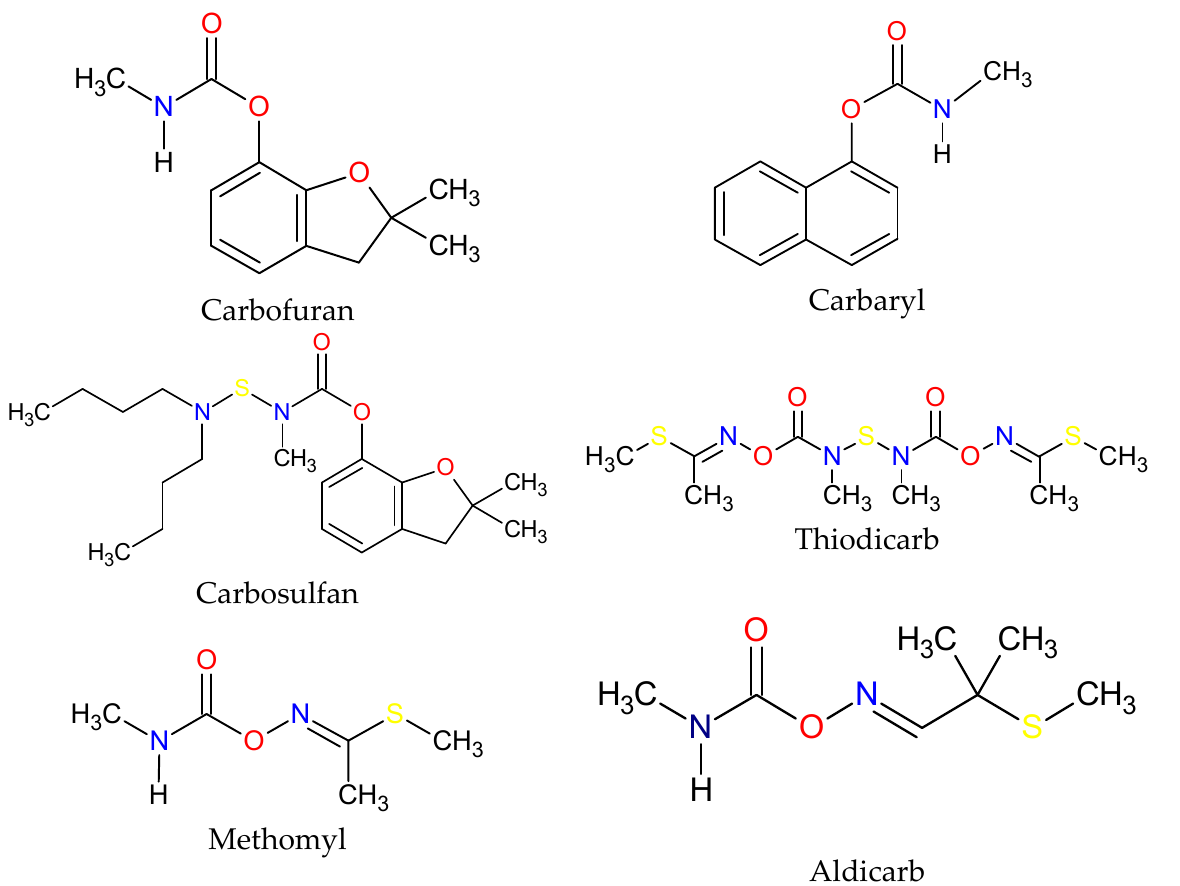
Figure 3. Structural formula of the main carbamates.